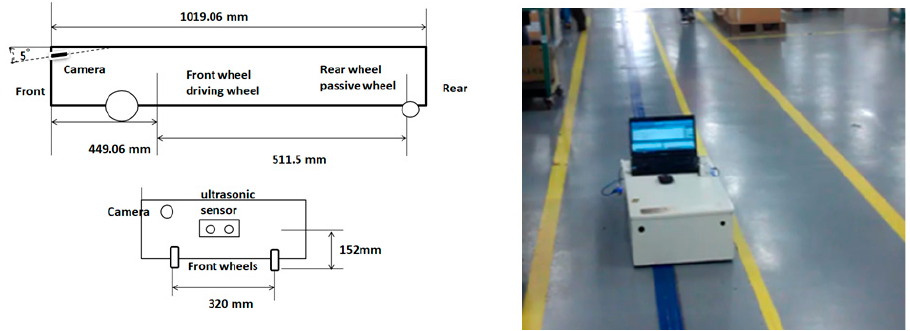
Figure 1. Hardware architecture of unmanned vehicle.